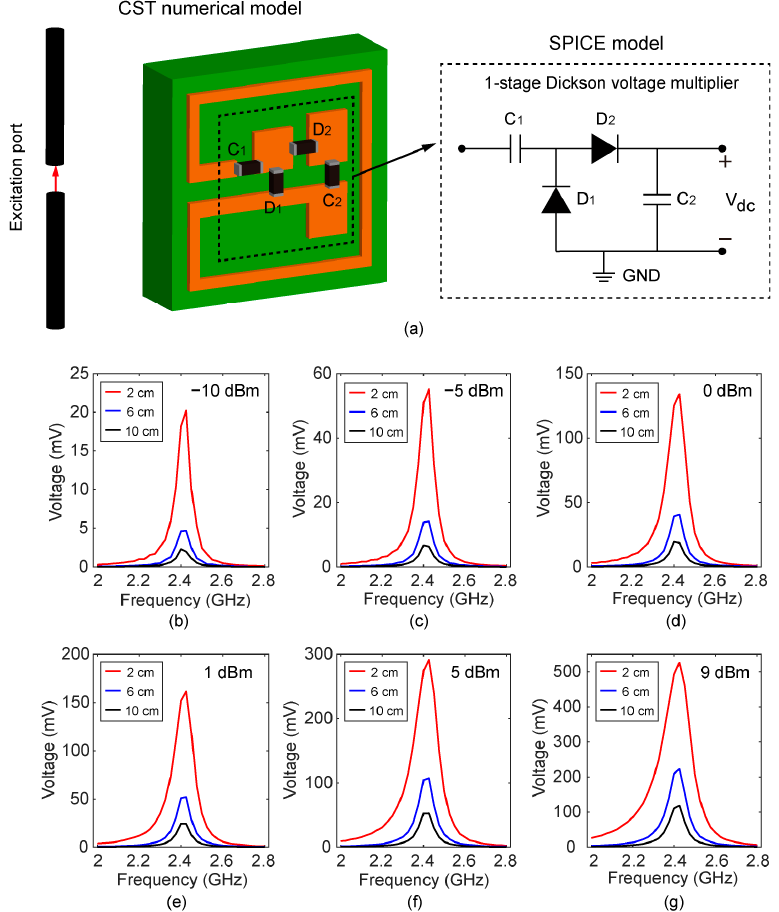
Figure 4. ( a ) The system-level simulation model to analyze the wireless energy-harvesting capability of MIA. Simulated output DC voltage (open circuit) versus frequency under different transmitting powers: ( b ) − 10 dBm, ( c ) − 5 dBm, ( d ) 0 dBm, ( e ) 1 dBm, ( f ) 5 dBm, and ( g ) 9 dBm.